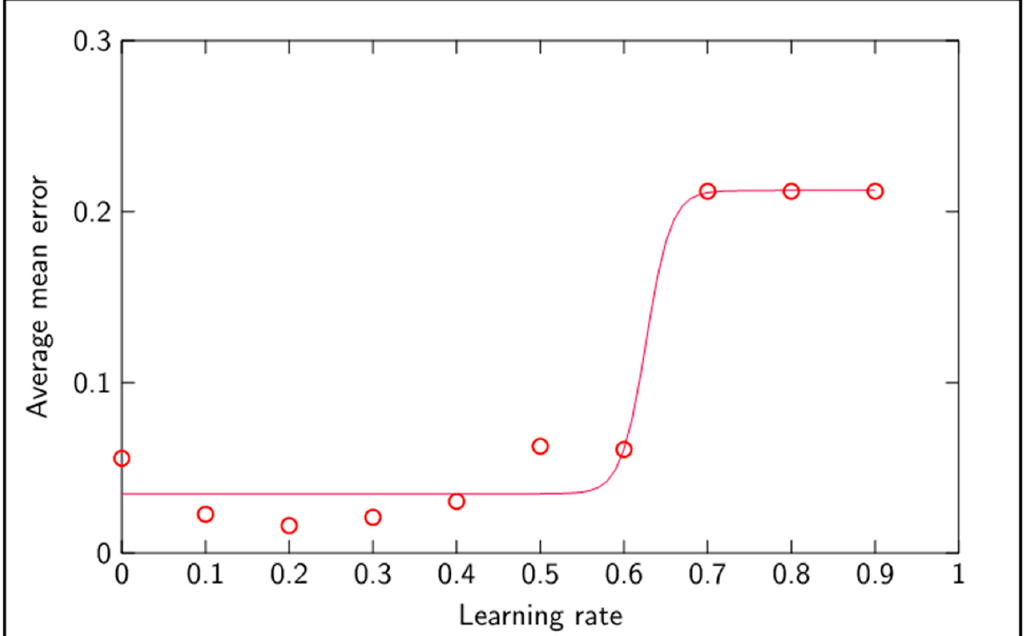
Figure 8. Average classification mean error versus learn rate.